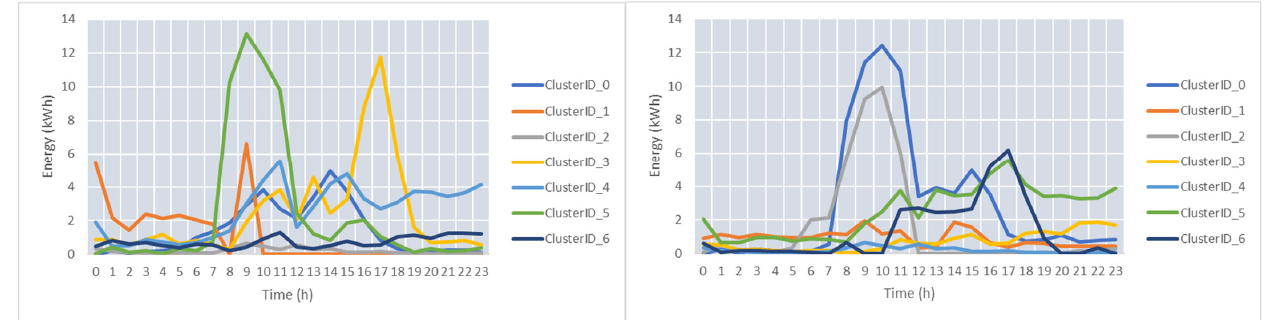
Figure 9. Energy peak ( left ) and valley ( right ) cluster centers profiles for TC-S2 and TC-S3.